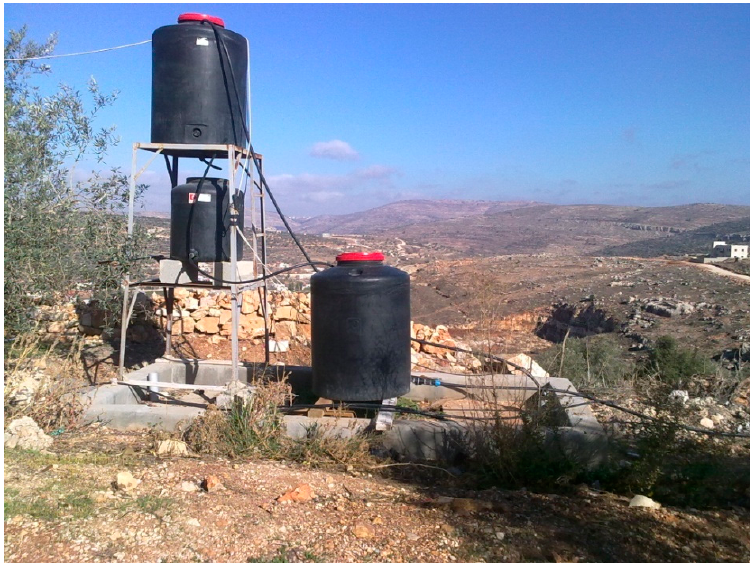
Figure 1. Onsite grey water treatment plant, Duara Al Qare’-Ramallah. Water 2020 , 12 , x